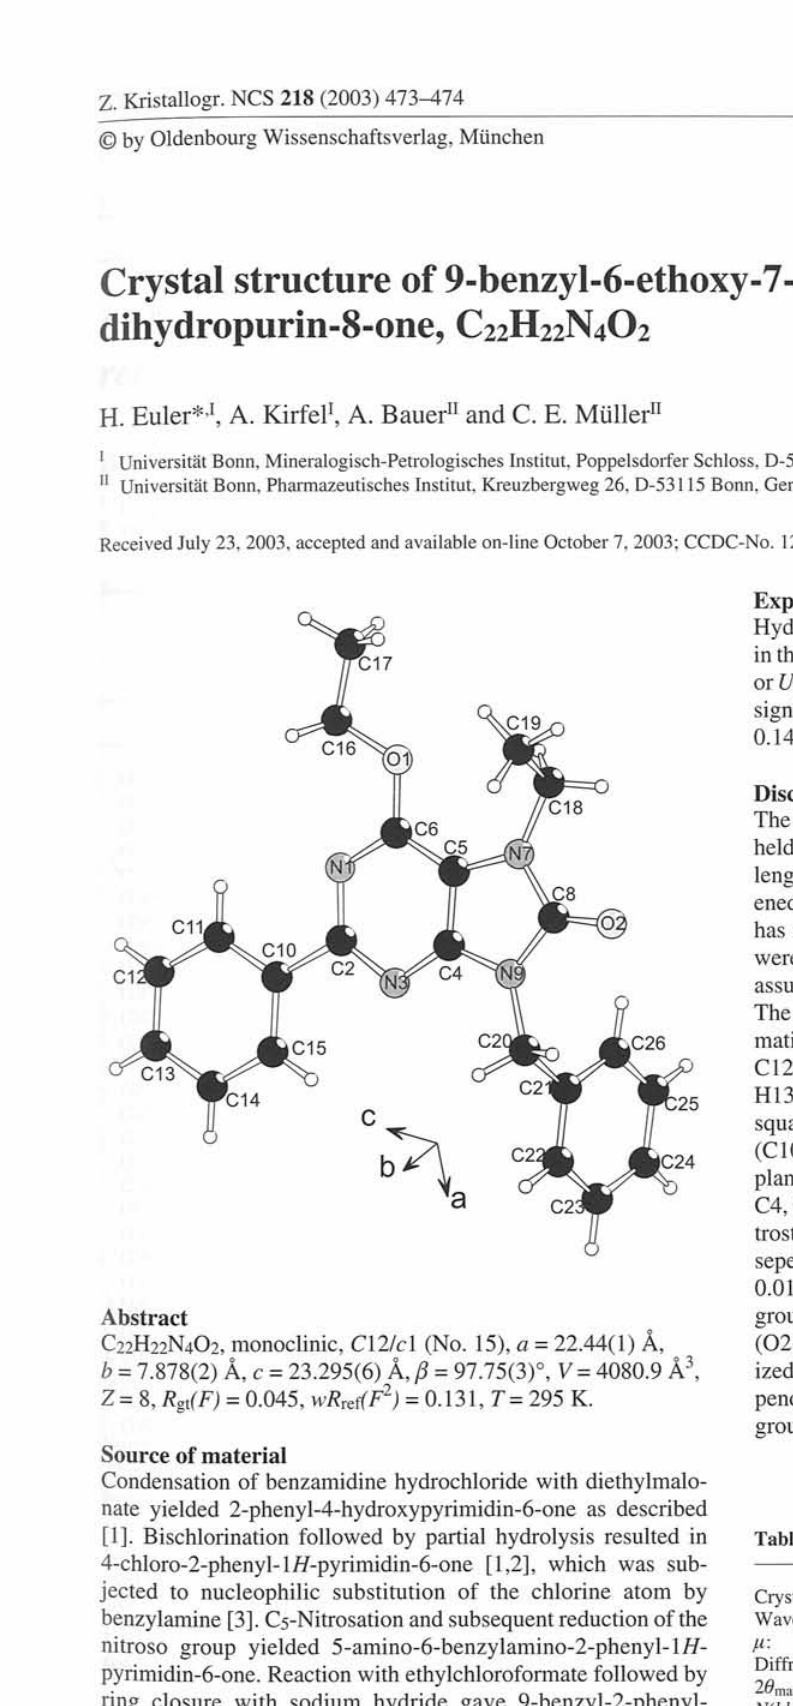
Table 1. Data collection and